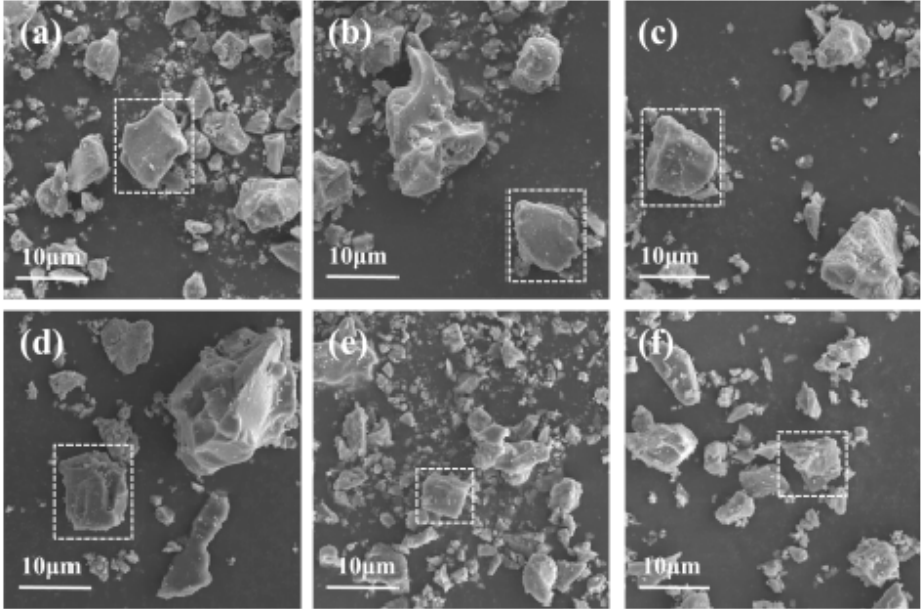
Figure 5. Microscope analyzed by SEM: ( a ) 1100 °C, 20 w t.% SrSO 4 , ( b ) 1200 °C, 20 w t.% SrSO 4 , ( c ) 1300 °C, 20 w t.% SrSO 4 , ( d ) 1100 °C, 30 w t.% SrSO 4 , ( e ) 1200 °C, 30 w t.% SrSO 4 , and ( f ) 1300 °C, 30 w t.% SrSO 4 .